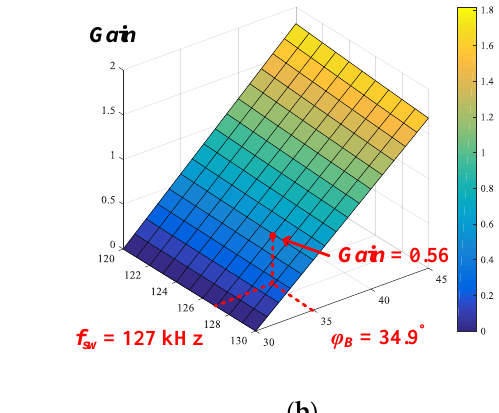
Figure 15. Simulation results of switching frequency versus phase shift degree at a 50% output load: ( a ) module A with L rA = 20 μH, ( b ) module B with L rB = 16 μH.